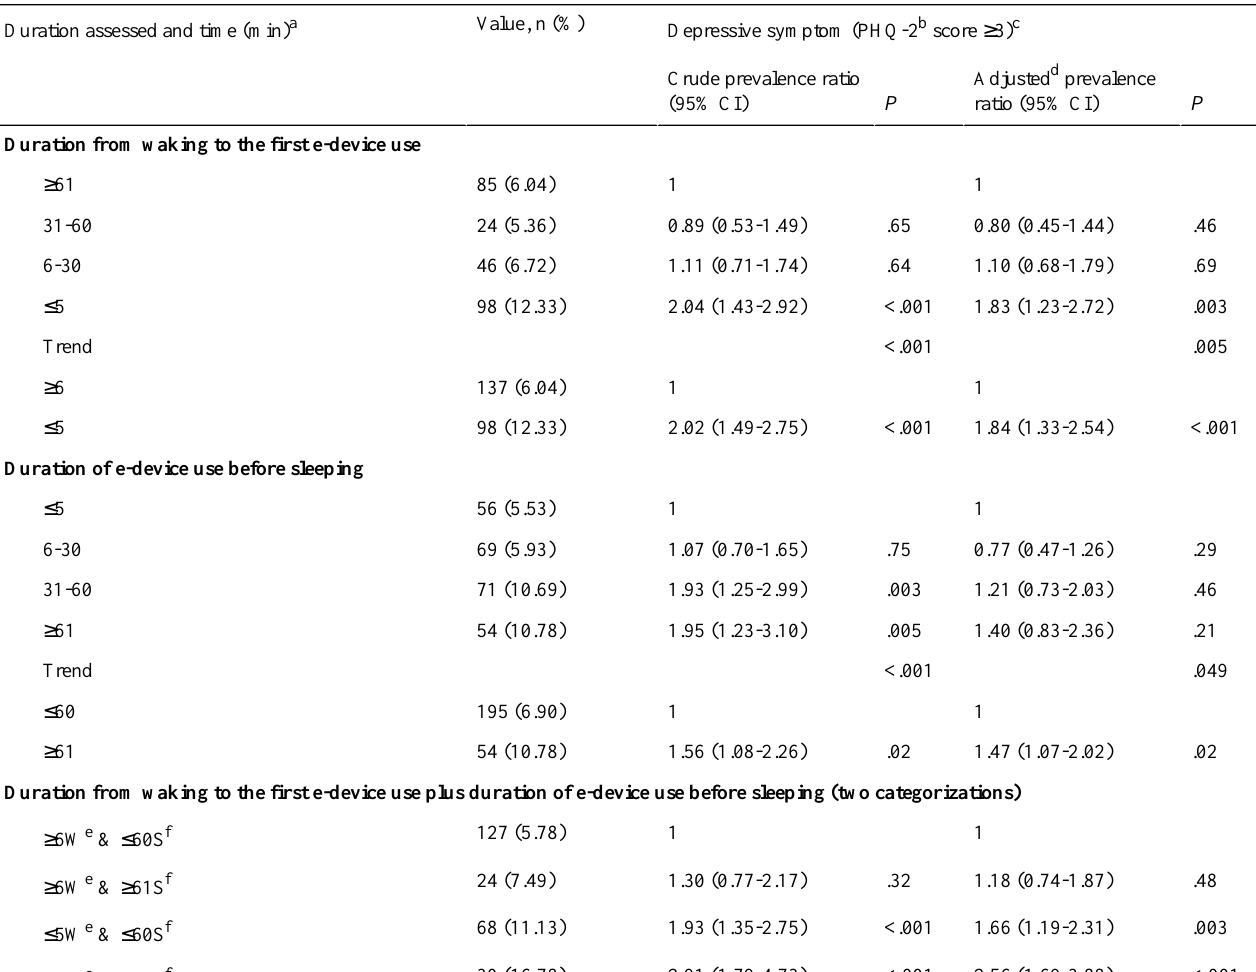
Table 5. Poisson regression of depressive symptoms for the duration from waking to the first e-device use and duration of e-device use before